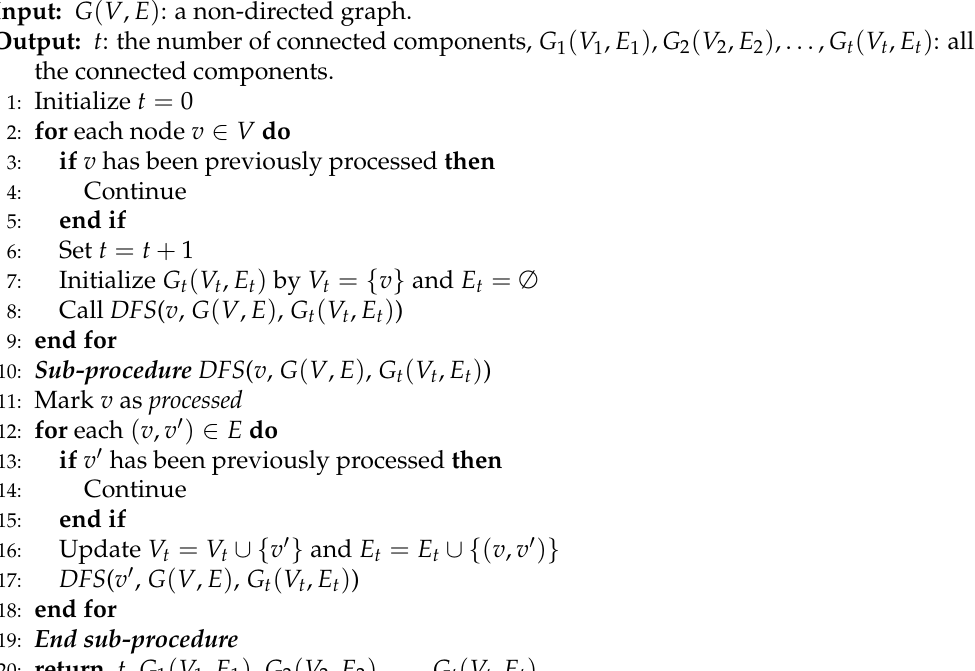
Figure 4. An example for constructing the graph: ( a ) Cover image, ( b ) Constructed graph. The pixels in the gray region are used for data embedding. The displayed values in the gray grids are the prediction values of the corresponding pixels. By setting T d = 2, the corresponding graph is constructed as shown in ( b ). Algorithm 1 The pseudo-code to collect all the connected